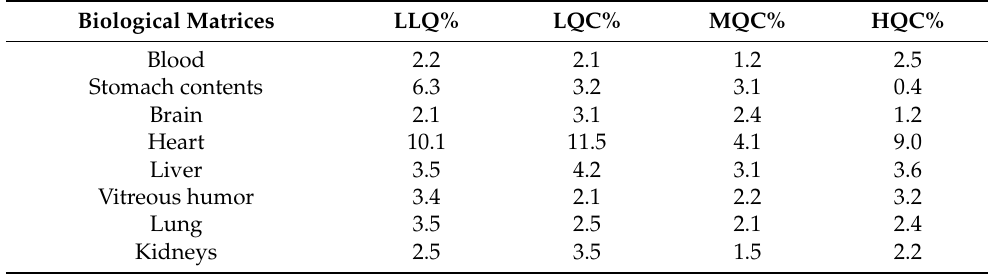
Table 7. Precision in each matrix for 3-OH- carbofuran was evaluated by means of the coefficient of variation (CV%) of the lower limit of quantification (LLQ), low-quality control (LQC), medium-quality control (MQC), and high-quality control